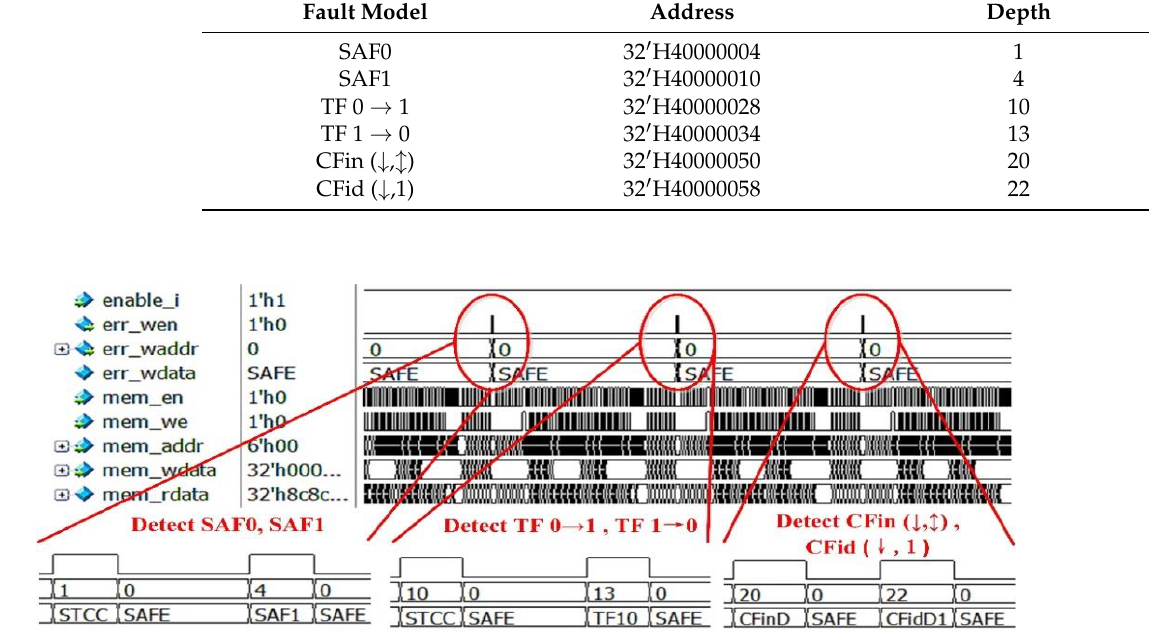
Figure 9. Detection Result for Faults.